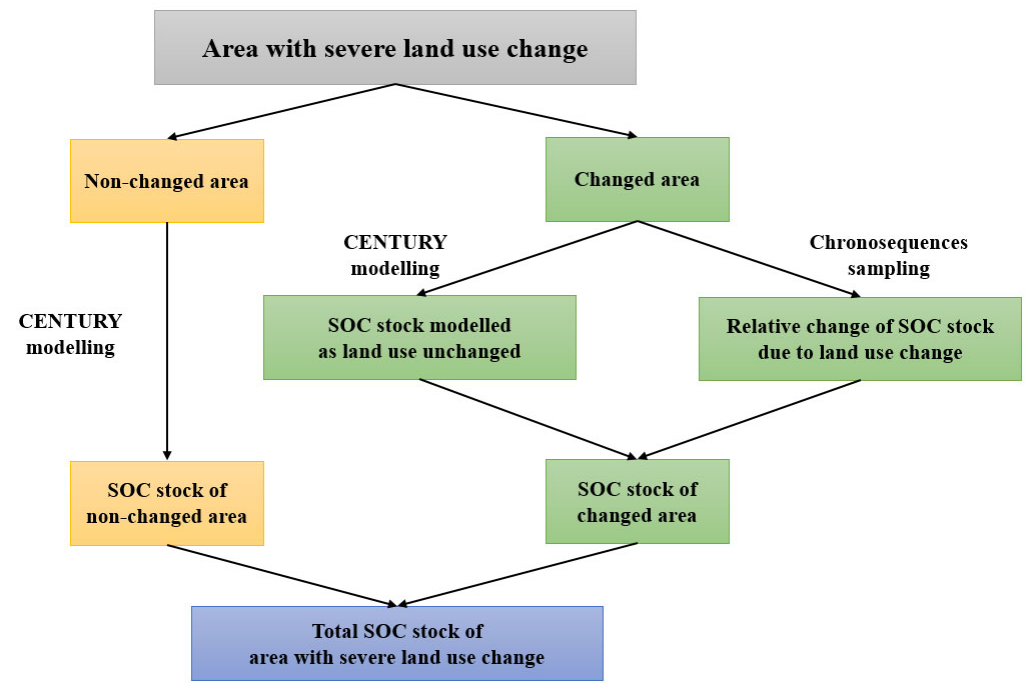
Figure 2. CMCS Framework for estimating SOC in areas with a large land use change.